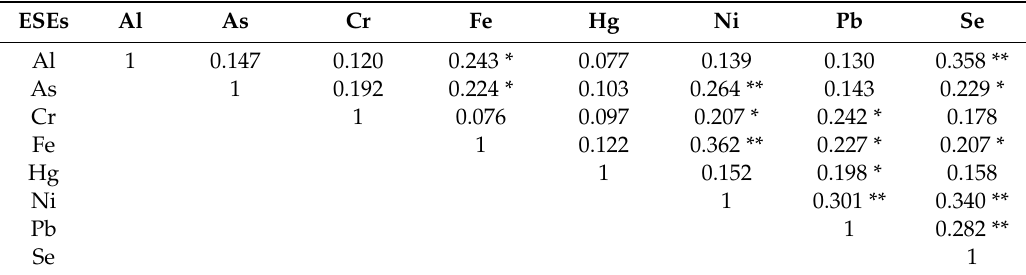
Table 2. Pearson’s correlation matrix during premonsoon period.